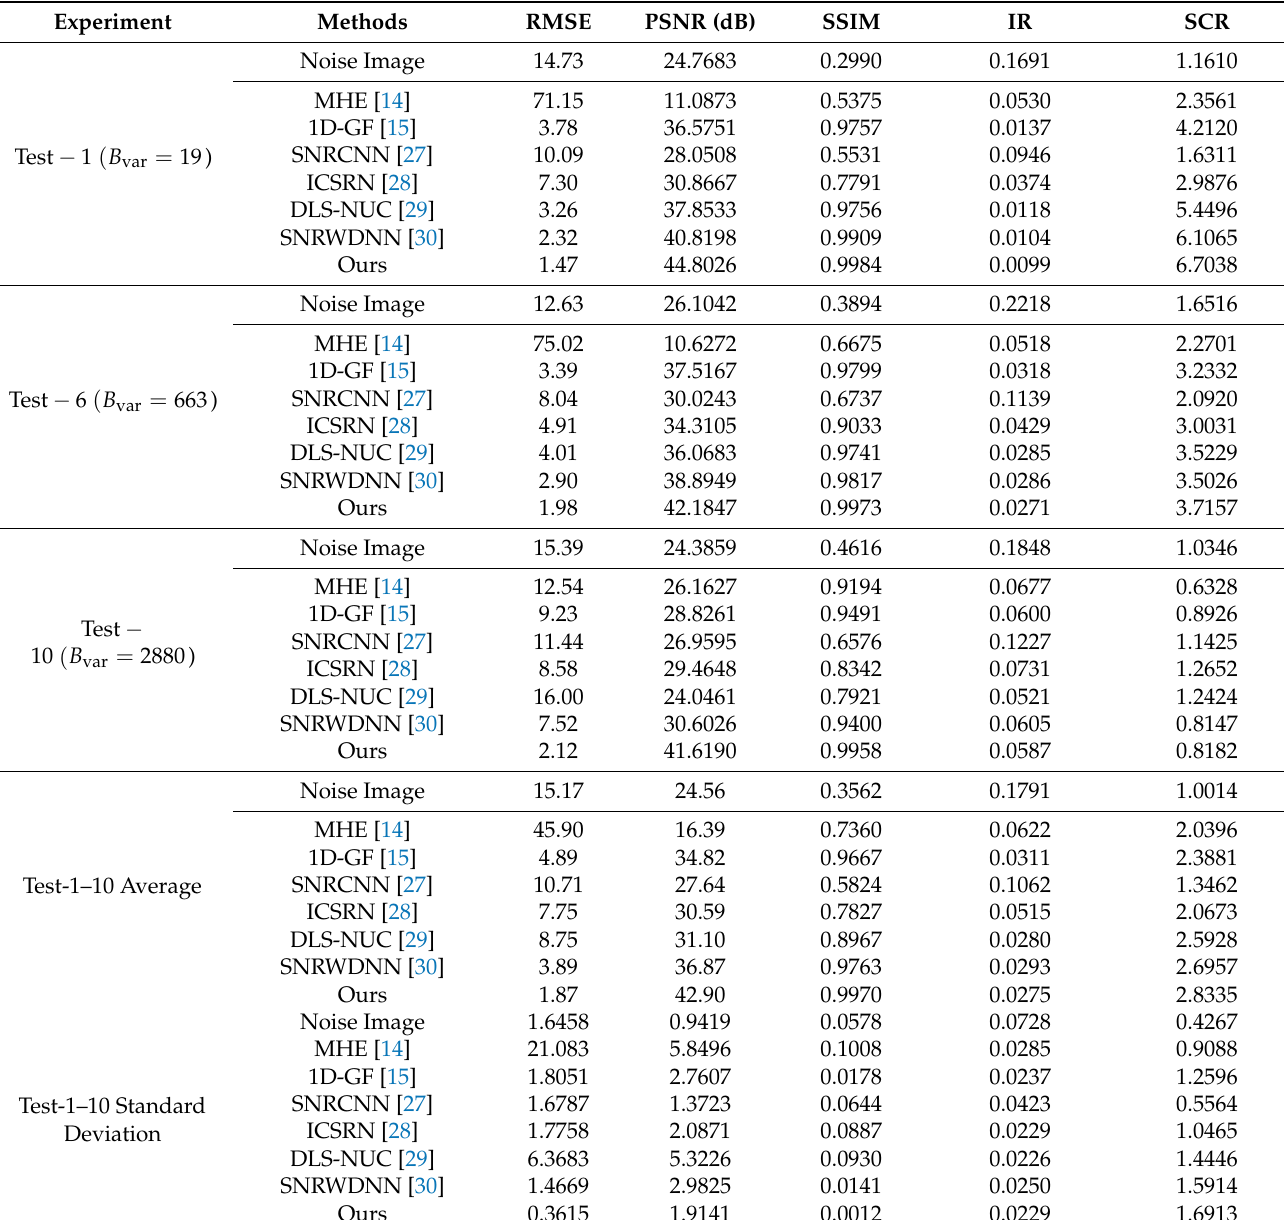
Table 2. Evaluation metric results of the methods on simulated data with different